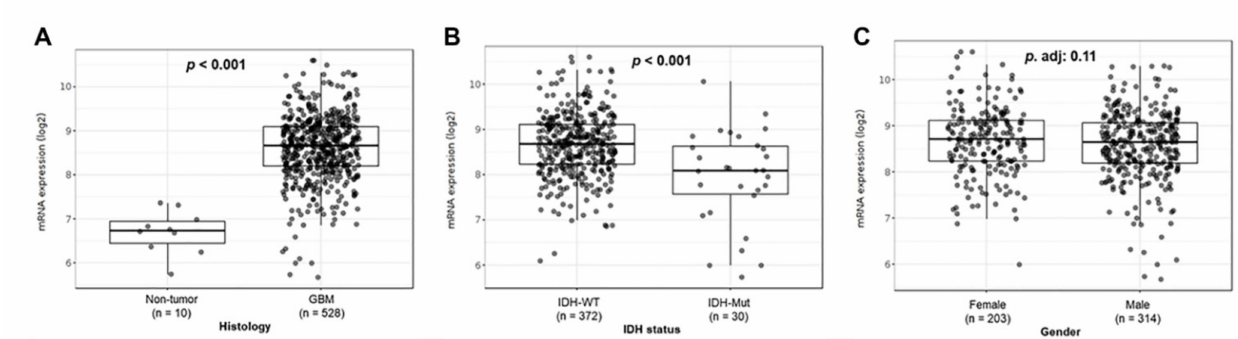
Figure 1. TSPO gene-expression analysis in TCGA-GBM cohort. Patient GBM samples from the TCGA-GBM database, using the platform Affymetrix HG-U133A, were analyzed using GlioVis. ( A ) mRNA expression levels in GBM samples compared to tumor-free brain samples. ( B ) Expression levels of TSPO in GBM patients grouped by IDH status (IDH-WT vs. IDH-Mut). ( C ) TSPO expression levels between males and females with GBM. The number of patients (n) and p -value of the pairwise comparisons using t -test (with Bonferroni correction) are indicated in each